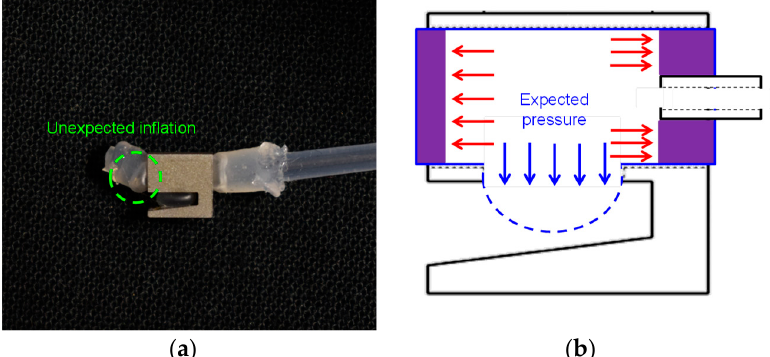
Figure 4. The failure mode of the conventional inflation actuator: ( a ) the unexpected inflation at the connection parts between the silicones and the soft pneumatic channel; ( b ) the cause of the unexpected inflation (the red arrows represent unexpected pressure).